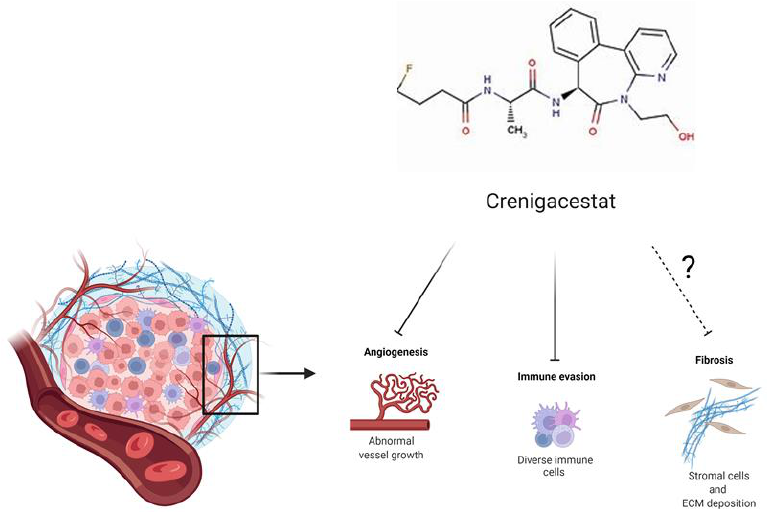
Figure 10. Schematic illustration of this study.